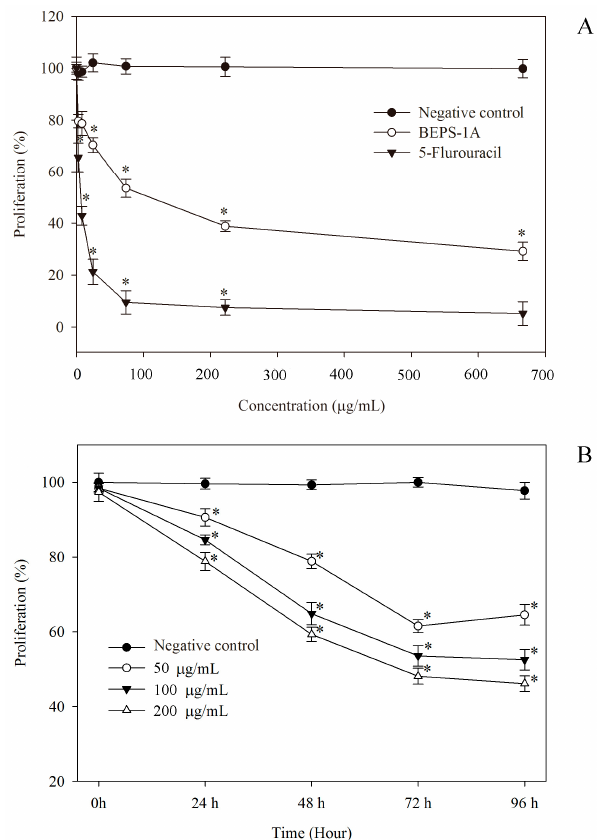
Figure 5. Growth inhibitory effect of B. exarata polysaccharide-protein complex BEPS-IA on HepG2 cells. ( A ) HepG2 cells were treated with various concentrations of BEPS-IA for 72 h; ( B ) The antiproliferative activity of BEPS-IA (0, 50, 100 and 200 μ g/mL, respectively) on the HepG2 cells growth at 24, 48, 72 and 96 h. Untreated cells (0 μ g/mL) group was used as negative control and 5-fluorouracil (5-FU) group was used as a positive control. The data were expressed as mean ± SD of three experiments. Values marked with * are significantly different compared to the control ( p <